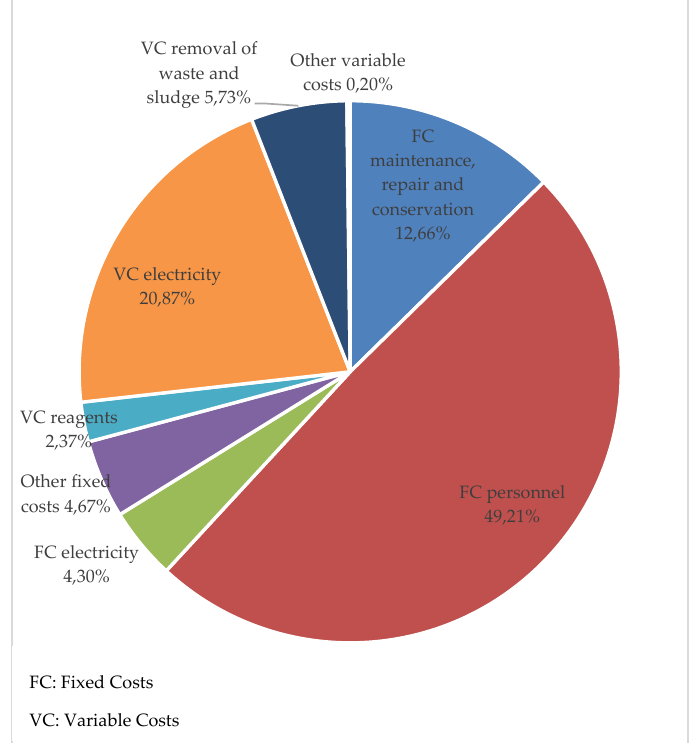
Figure 2. Structure of the average operation and maintenance costs per m 3 of treated wastewater in the province of Jaén.